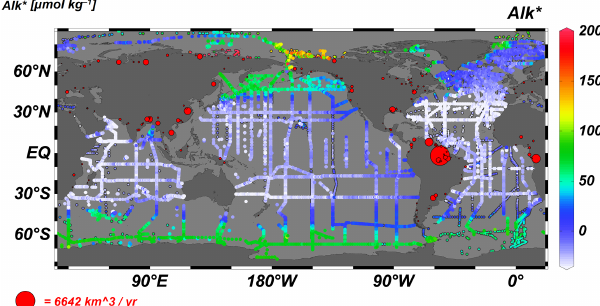
Figure 1. A map of station locations at which we use measurements to estimate Alk ∗ (in µmolkg − 1 ). Dot color indicates surface Alk ∗ . Points with black borders indicate either that AT was measured prior to 1992 (i.e., before reference materials were commonly used) or that no nitrate value was reported (in which case a nitrate concen- tration of 5µmolkg − 1 is assumed). Red dots on land indicate the mouth locations and mean annual discharge volumes (indicated by dot size) of 200 large rivers, as given by Dai and Trenberth